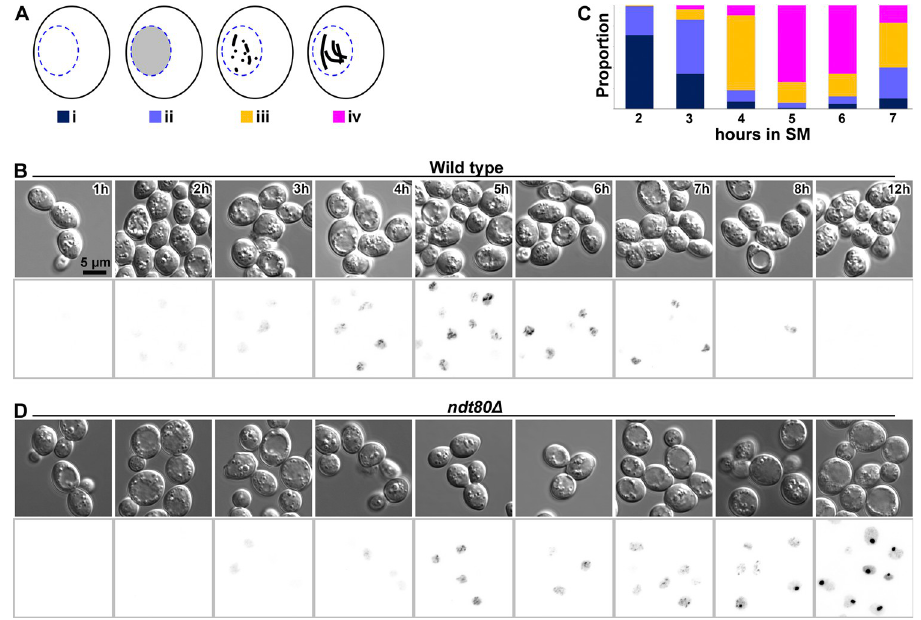
Fig 1. Meiosis monitored by their SC assembly states. (A) Cartoon of the different classes of Zip1-GFP fluorescence in meiotic prophase. i, non-fluorescent; ii, diffuse fluorescence; iii, punctate fluorescence; iv, string-like fluorescence corresponding to full-length SCs. The nucleus is blue and the Zip1-GFP signal is gray/black inside the nucleus. This schematic is based on White, et al. [20]. (B) Time course of WT cells expressing Zip1-GFP in SM. Diffuse fluorescence started to appear after 2 hours and became punctate between 3 and 4 hours. Long linear SCs appeared after 5 hours in SM and became rarer after 7 hours. The right-most brightfield image shows WT cells after 12 hours in SM. Each ascus contained four spores. Upper panels: differential interference contrast; lower panels: Zip1-GFP fluorescence in inverted contrast. (C) Time course for SC formation in WT cells based on the Zip1-GFP fluorescence pattern. Approximately 100 cells were sampled at each time point. The color scheme is indicated under each cartoon in panel A. (D) Time course of ndt80 Δ cells incubated in SM. Upper panels: differential interference contrast; lower panels: Zip1-GFP fluorescence in inverted contrast. Time points are the same as for panel B. The strong fluorescent signals in the 8- and 12-hour time points are polycomplexes.